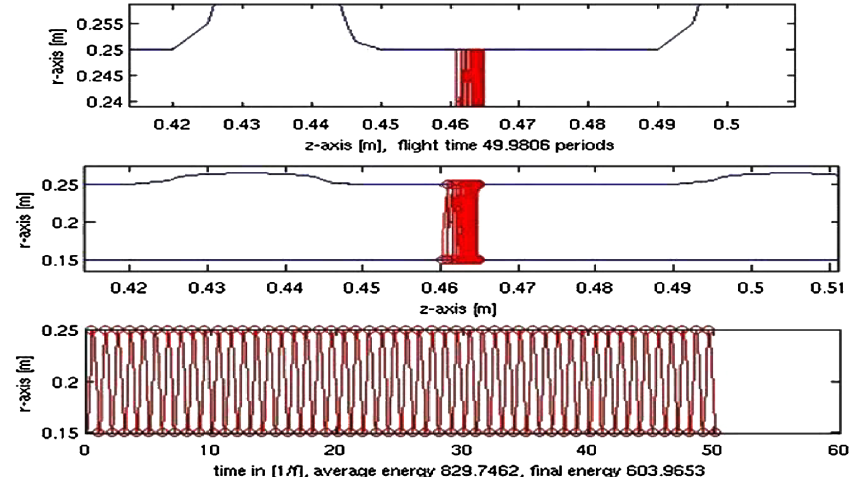
impacts.FIG. 15. (Color) Multipacting trajectory with a 4 cm gap between the